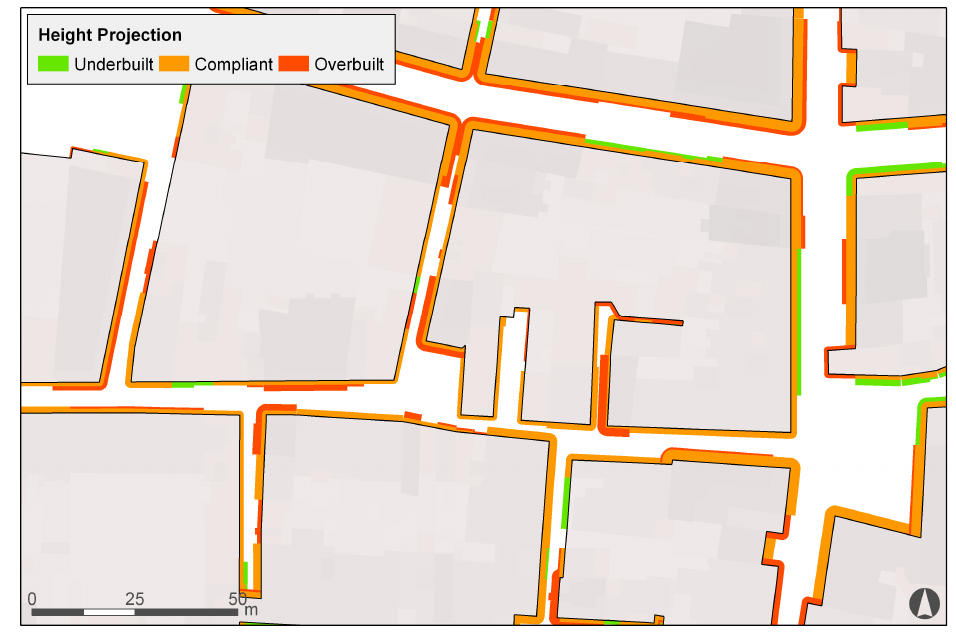
Figure 17. Height projected onto the ground plane colored by legal status.